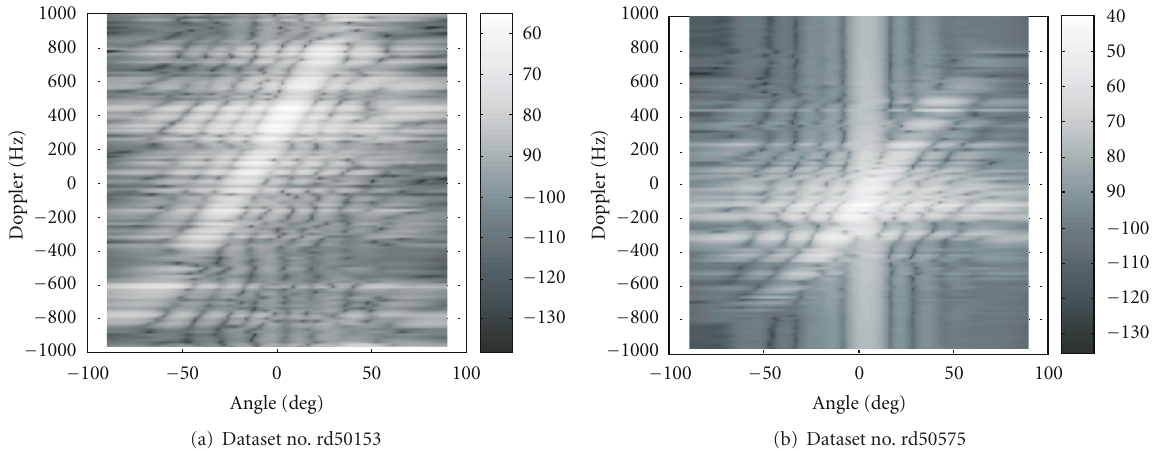
Figure 7: Angle Doppler Map of the MCARM dataset no. rd50575 (range cell number 200 is chosen).